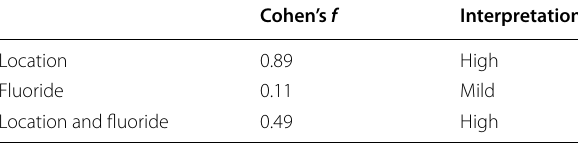
Table 2 Effect size for fluoride, location and their